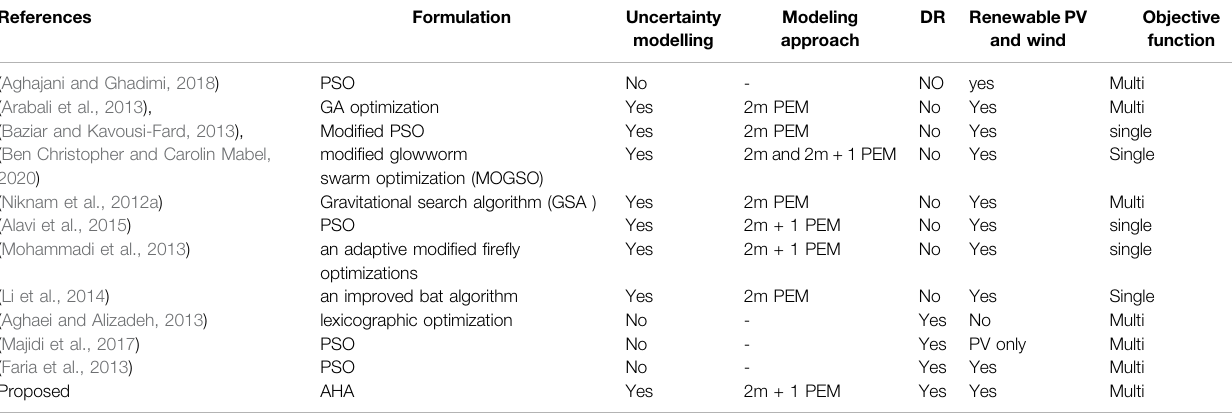
TABLE 1 | A summary of the relevant literature.